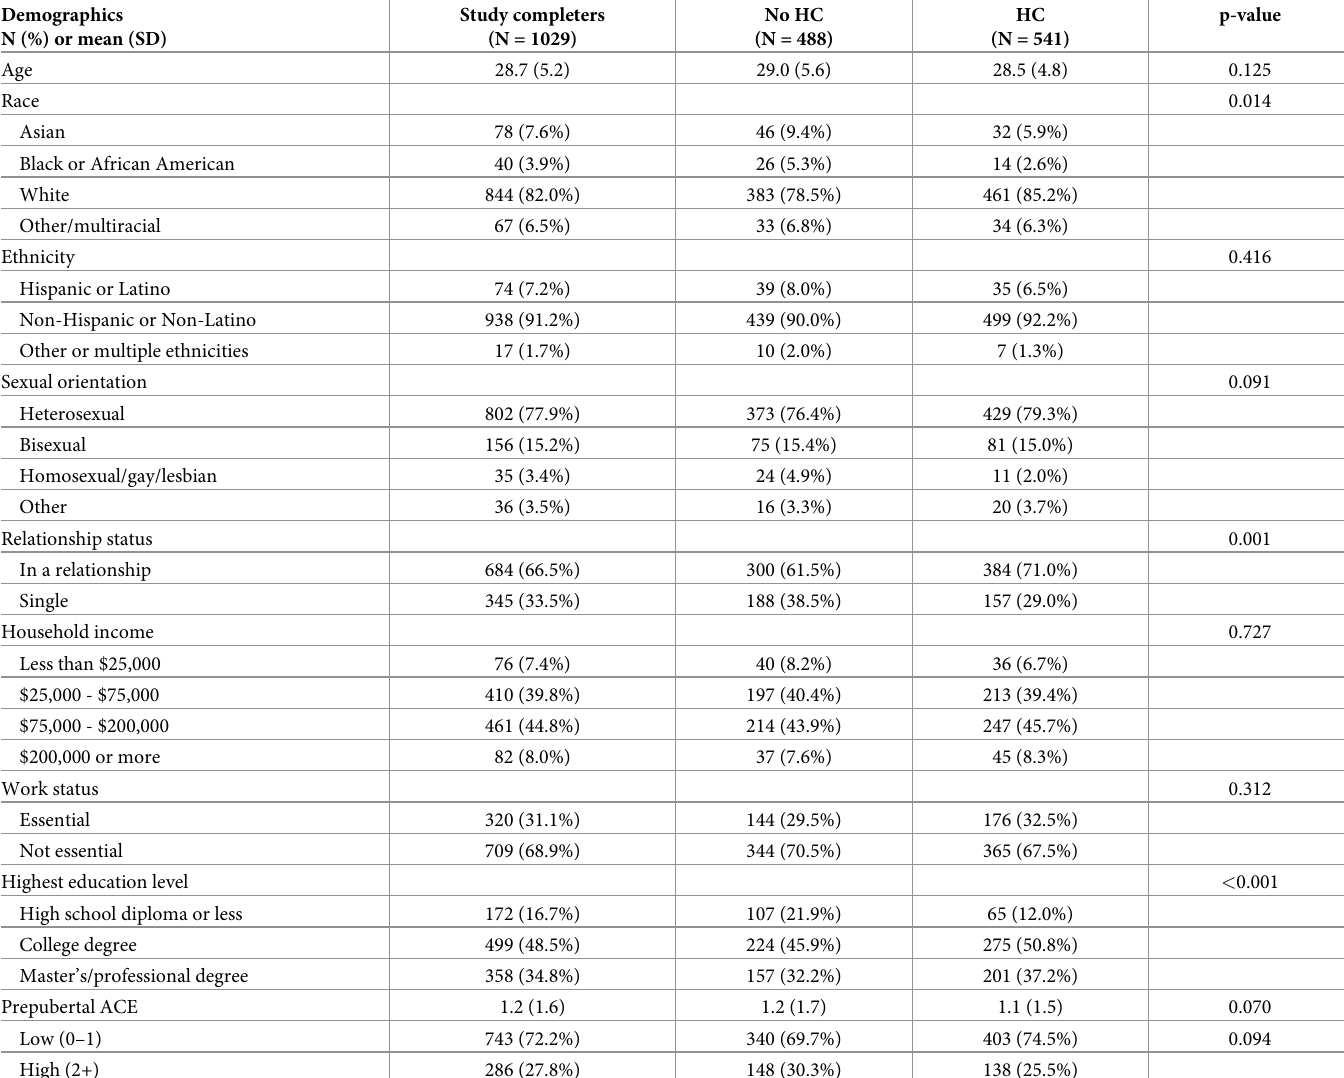
Table 1. Demographics of study completers stratified by whether they use hormonal contraception (HC). Demographics N (%) or mean